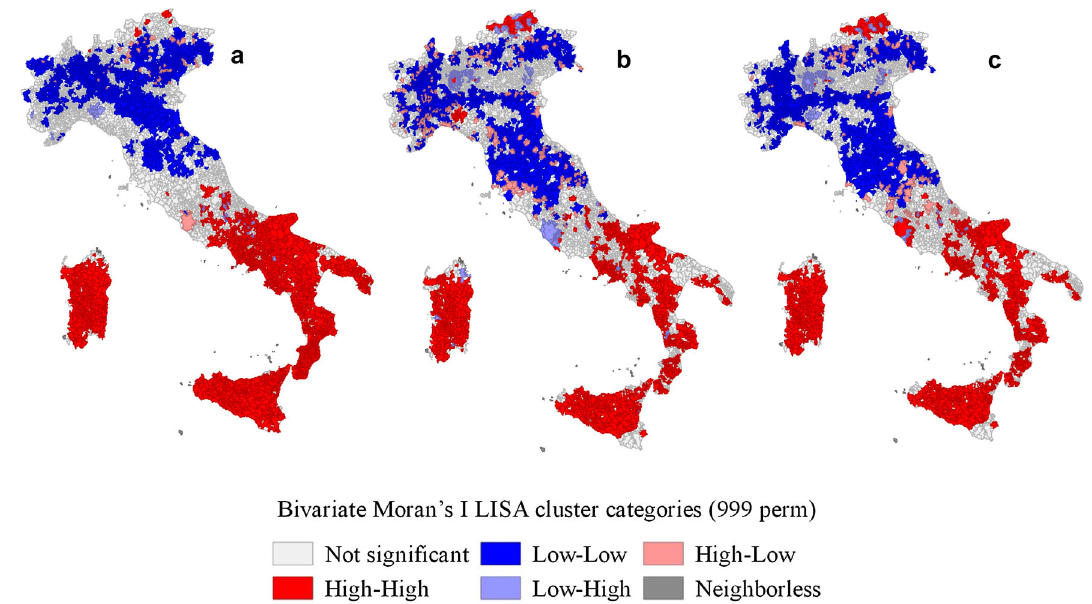
Fig. 6 Italy’s changing social vulnerability as shown by bivariate LISA cluster maps of SVI in the periods considered. a 1991–2001; b 2001–2011; and c 1991–2011. Significance of the test statistic was